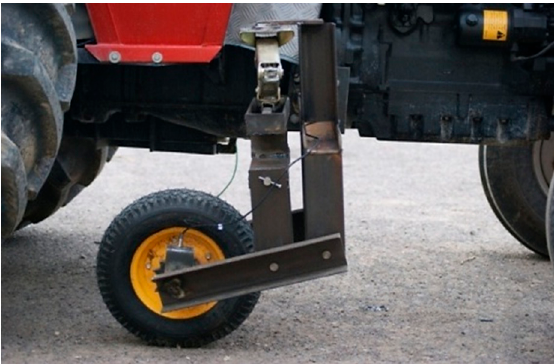
Figure 2. Adjustable fifth-wheel to measure the forward speed of the tractor.